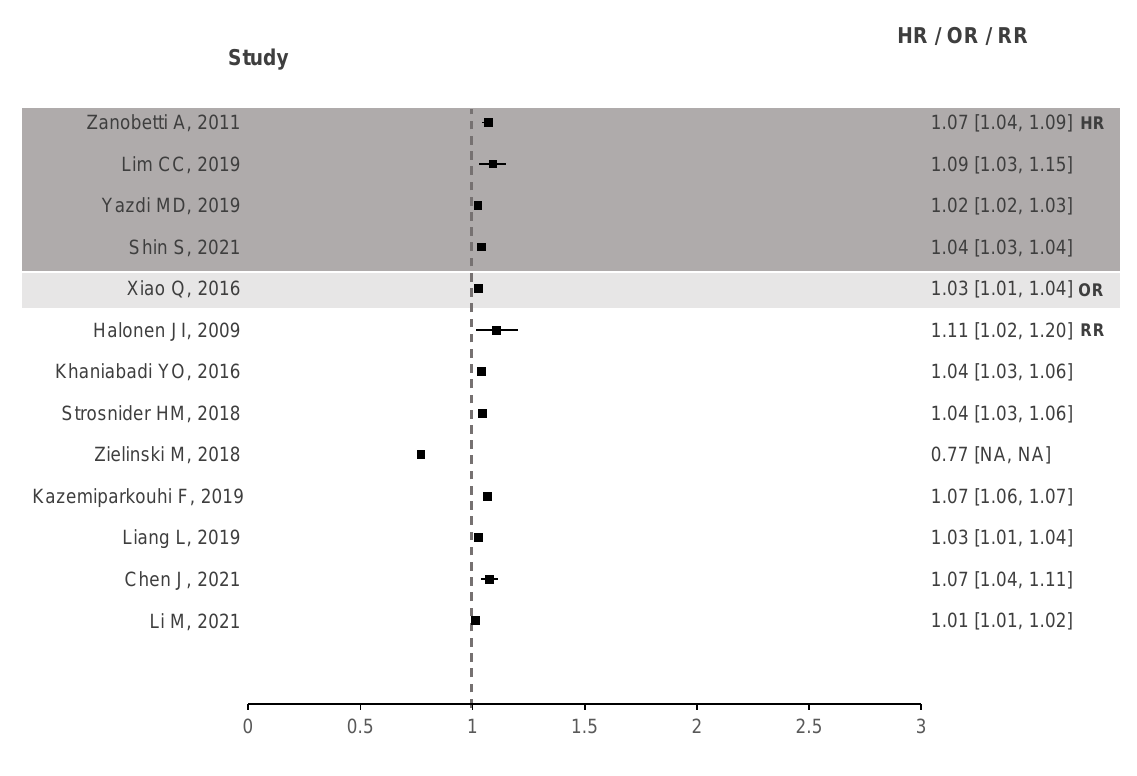
Figure 5. COPD forest plots of O 3 increased risk results.